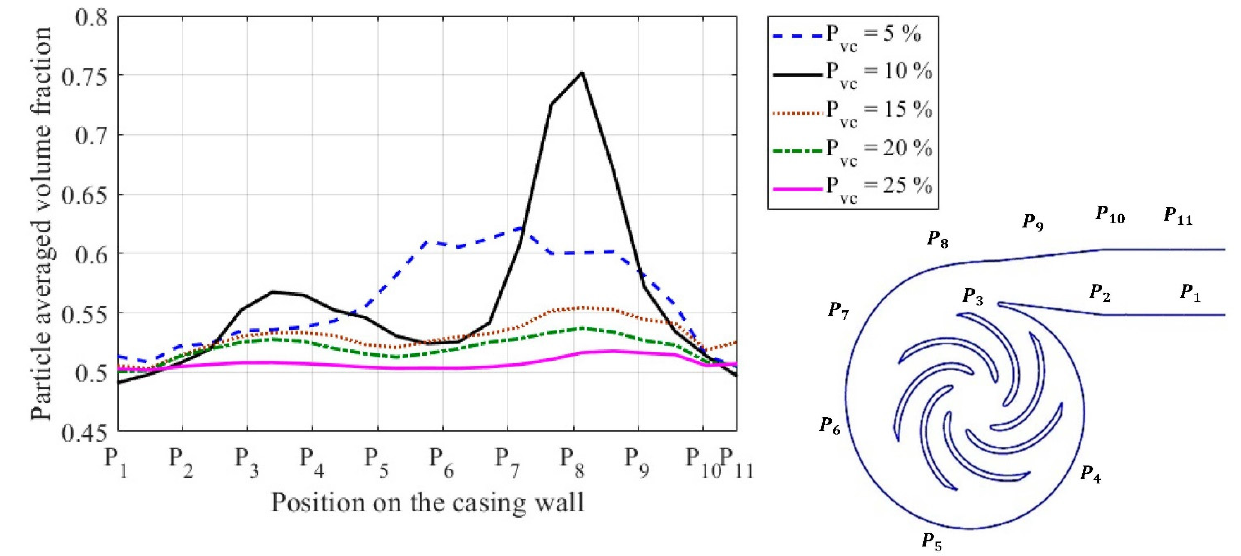
Figure 8. Variation of the concentration of particles along the casing wall with different values of volumetric concentration of the solid particles.